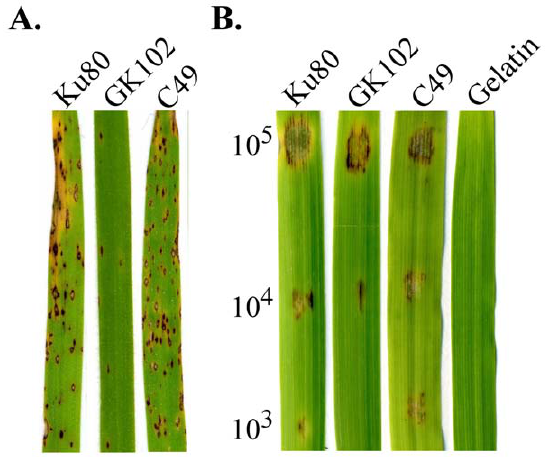
Figure 4. Infection assays with the Mosfl1 mutant. A. Seedlings of rice cultivar CO-39 were sprayed with conidia of Ku80, Mosfl1 mutant GK102, and complemented transformant C49. Typical leaves were photographed 7 days post inoculation (dpi). B. Detached barley leaves were drop inoculated with conidia from the same set of strains. The concentrations of conidium suspensions (conidia/ml) were marked on the left. Inoculation with 0.25% gelatin was the negative control. doi:10.1371/journal.pone.0019951.g004 PLoS ONE |